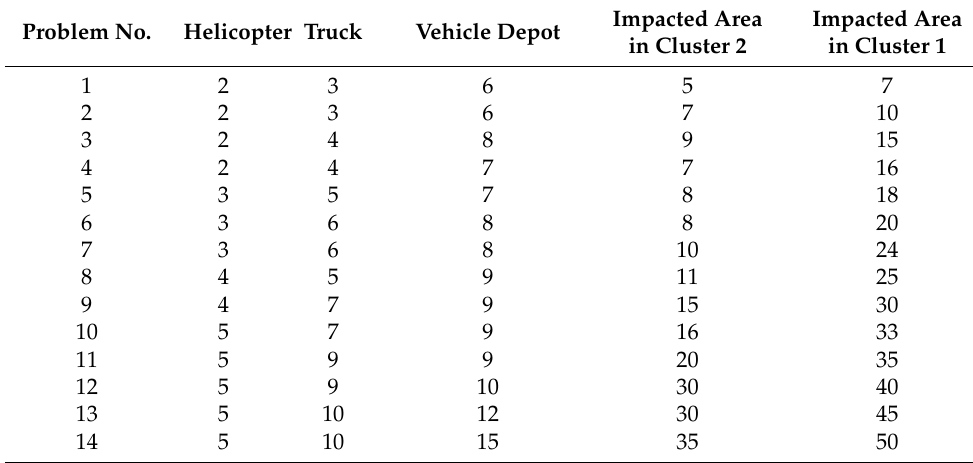
Table 5. Characteristics of generated sample problems.